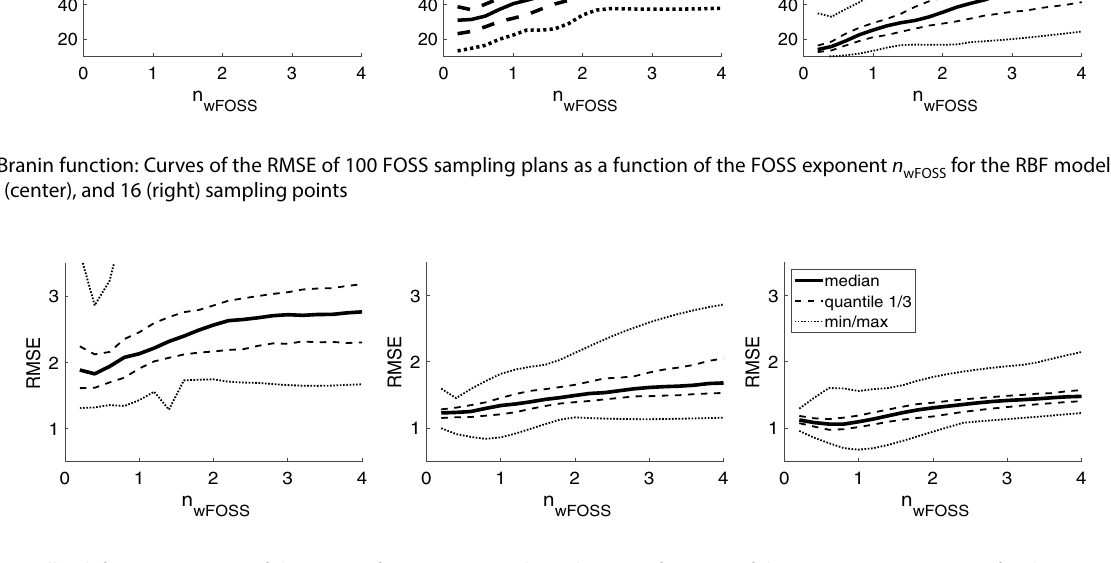
Fig. 8 Camelback function: Curves of the RMSE of 100 FOSS sampling plans as a function of the FOSS exponent n wFOSS for the DACE model with 4 (left), 9 (center), and 16 (right) sampling